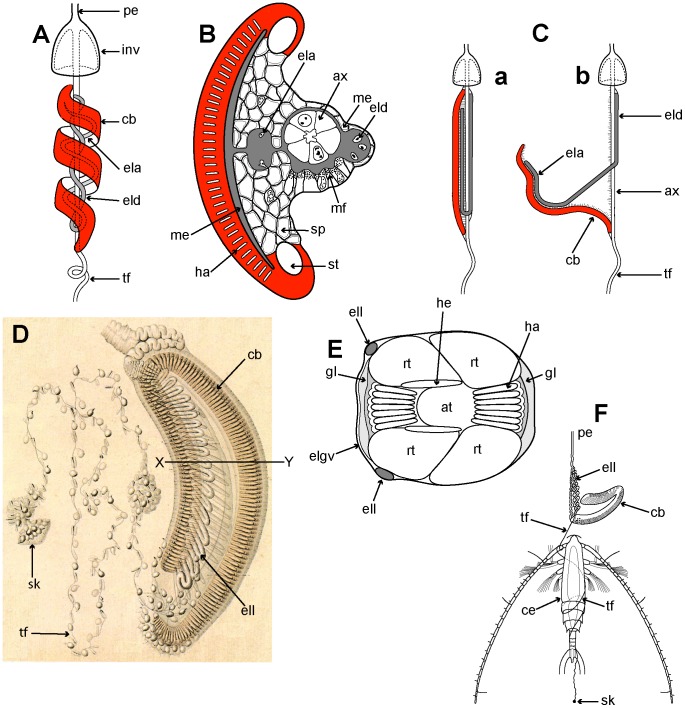
Tentillum discharge in siphonophores.A-C: Nanomia bijuga (redrawn from [155], A: fig. 2, schematic of undischarged tentillum; B: fig. 3, schematic section through tentillum; Ca & b: fig. 4a & b, schematic of tentillum discharge; D–E: Stephanophyes superba (after [151]); D: pl. 4, fig. 4, undischarged tentillum; E: txt fig. 3, schematic section through tentillum at X-Y; F: txt fig. 4, discharged tentillum with captured copepod. Labels: at – artefact (not a natural cavity); ax – axis/axial canal (endodermal); cb – cnidoband; ce – entangled copepod; ela – ascending elastic strand; eld – descending elastic strand; elgv – ectodermal lamella with red gastrovascular cells; ell – looped elastic strand; gl – glandular cells; ha – haploneme; he – heteroneme; inv – involucrum; me – mesogloea; mf – muscle fibres (in ectoderm); pe – pedicel; rt – reticulate (supporting) cell; sk – sinker; sp – spongy ectoderm; st – stenotele; tf – terminal filament.